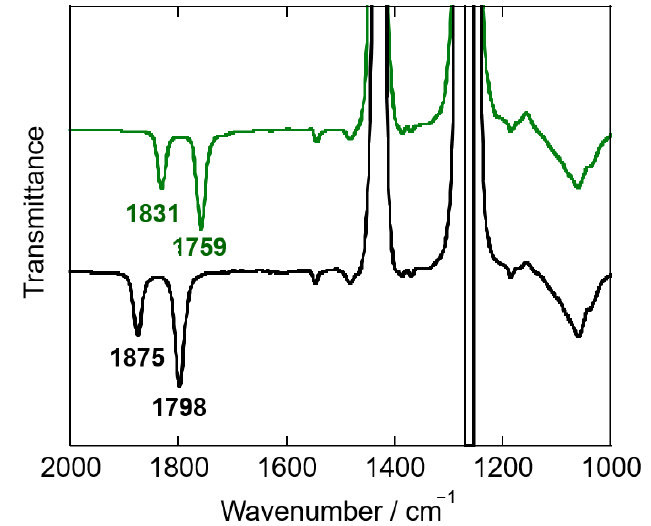
Figure 3. IR spectra of [Fe(NO) 2 (L1”)](BF 4 ) (green, top) and [Co(NO) 2 (L1”)](BF 4 ) (black, bottom) in solution (CH 2 Cl 2 solution (CH 2 Cl 2 ).